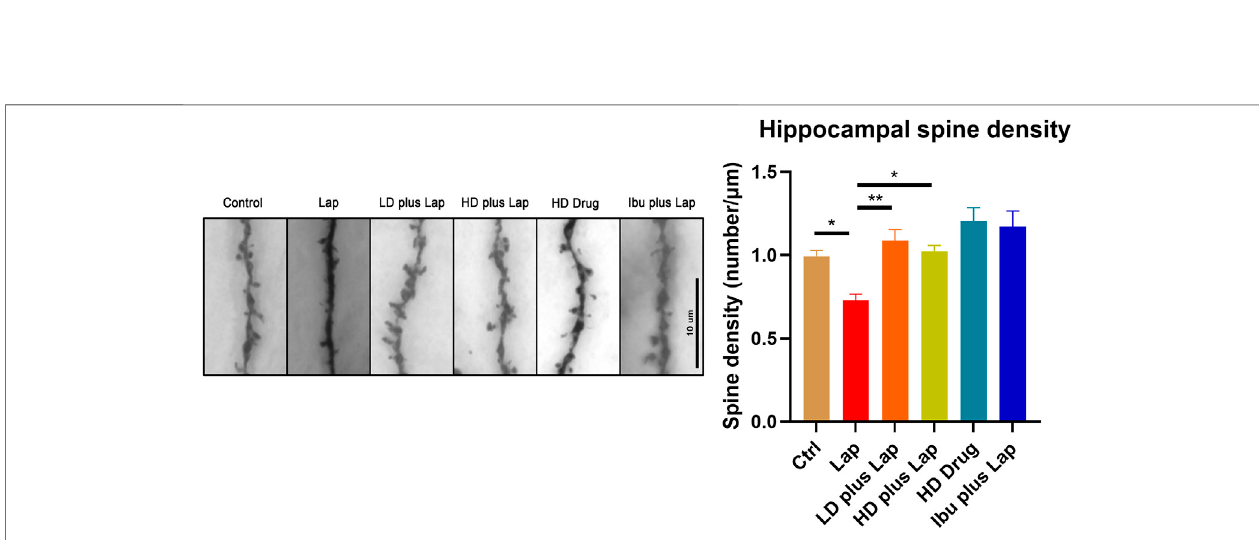
FIGURE 8 | D101 fraction preserved dendritic spine density in the hippocampus of postoperative mice. Dendritic spines in the hippocampus were visualized by Golgi staining. Left panel shows the representative images of dendritic spines in hippocampus. Decrease of spine density was observed in the hippocampus after surgery. With D101 fraction treatment, signi fi cant increase of spine density was found in postoperative mice. n = 10 in total, 2 – 3 dendrites were chosen at random from four mice in each group. Data are presented as the mean and SEM. * p < 0.05, ** p < 0.01 compared with laparotomy group. Values were analyzed by one-way ANOVA with Tukey post hoc